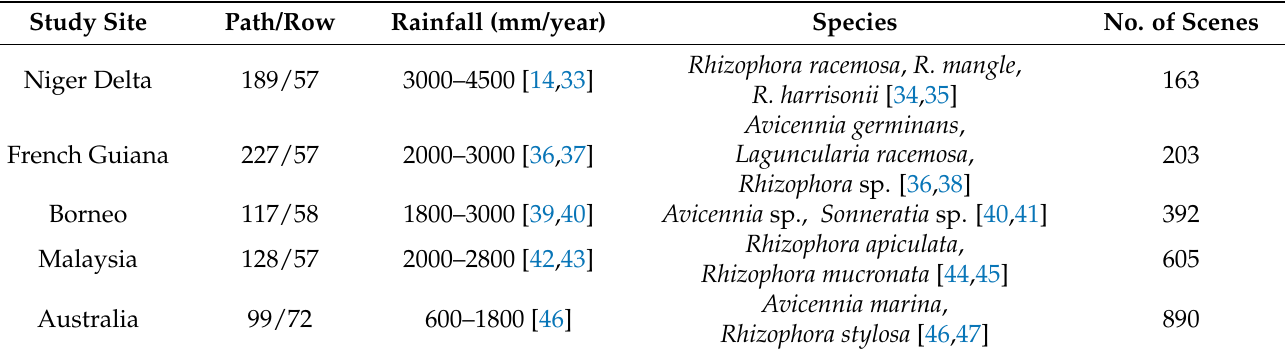
Table 1. Description of the five study